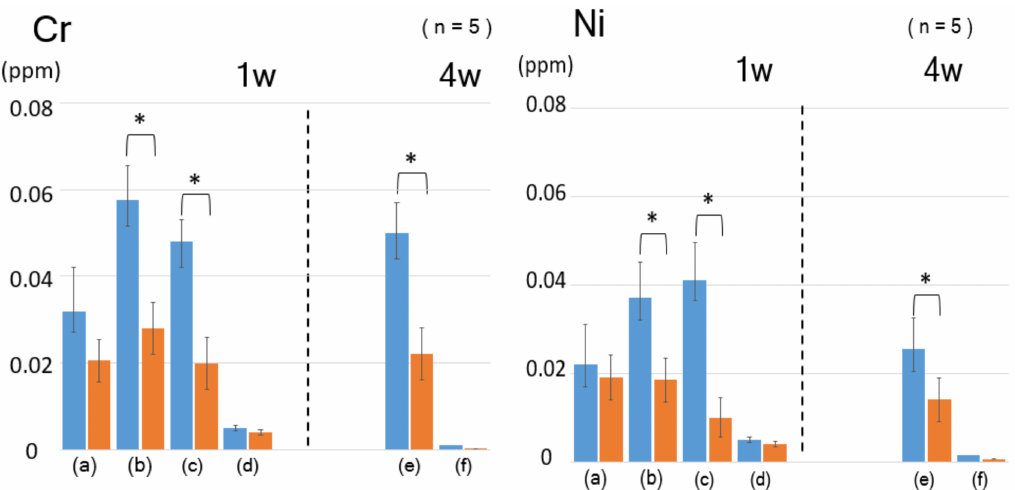
Figure 2. Concentration of the eluted metal ions from the ODPA-modified dental wire immersed in ( a ) 0.05 M HCl, ( b ) 0.1 M H 3 PO 4 , ( c ) 1 M lactic acid, ( d ) 0.1 M lactic acid for one week, ( e ) 0.1 M lactic acid, ( f ) saline for four weeks; left: Cr ions, right: Ni ions. ( p <